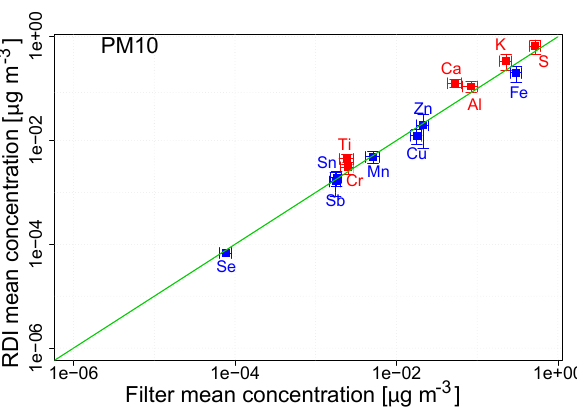
Fig. 1. Comparison of the mean values of nine PM 10 filter samples from high-volume samplers and RDI data. Elements measured at the X05DA beamline at SLS are displayed in red, elements mea- sured at HASYLAB L beamline are displayed in